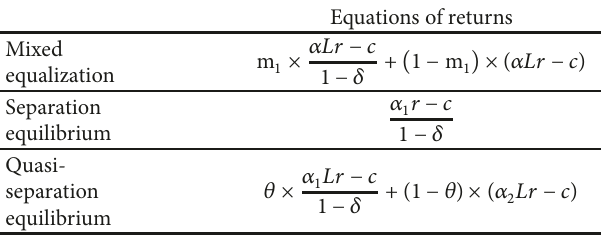
Table 6: Returns of banks.